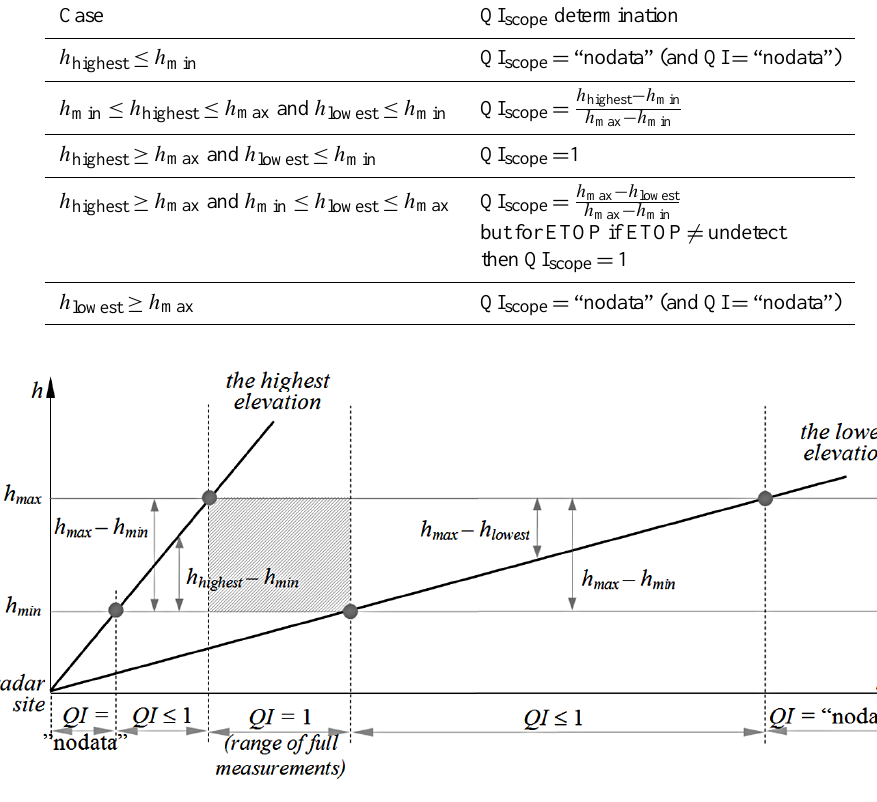
Figure 3. Quality QI Xscope determination for 2-D product in terms of fraction of scanned